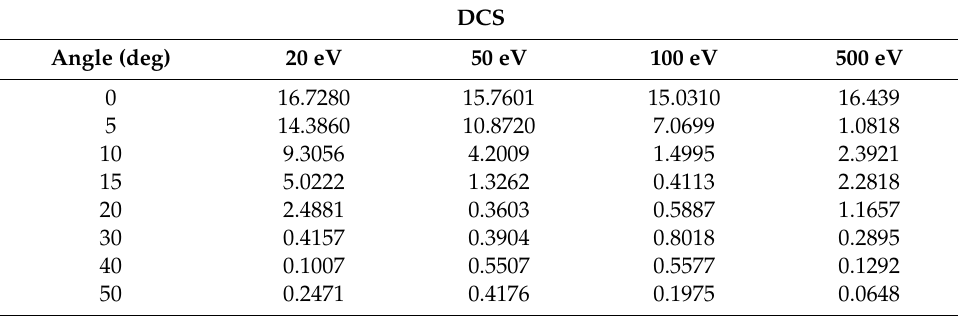
Table 4. Cross sections for positron-H 2 S scattering. The DCS is in units of 10 − 16 cm 2 /sr and ICS, MTCS, ACS and TCS are in units of 10 − 16 cm 2 .